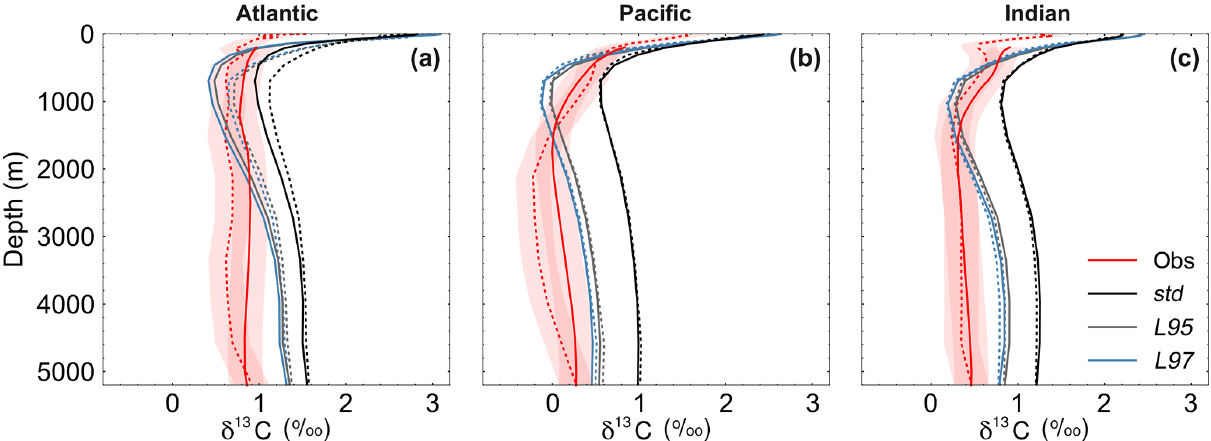
Figure 9. Depth profiles of δ 13 C DIC during the 1990s: (a) Atlantic Ocean, (b) Pacific Ocean, and (c) Indian Ocean. The δ 13 C DIC values in the std (black), L95 (grey) and L97 (blue) simulations are compared to observations (red). Solid lines are used for the global dataset, with observations from the gridded climatology produced by Eide et al. (2017). The simulated values have also been subsampled at the locations where there is a corresponding observation in the GLODAPv2 dataset (Key et al., 2015; Olsen et al., 2016; dashed). The red shading shows the estimated uncertainty in δ 13 C DIC observations due to unresolved intercalibration between different laboratories ( ± 0 . 2‰; Schmittner et al., 2013; Eide et al.,